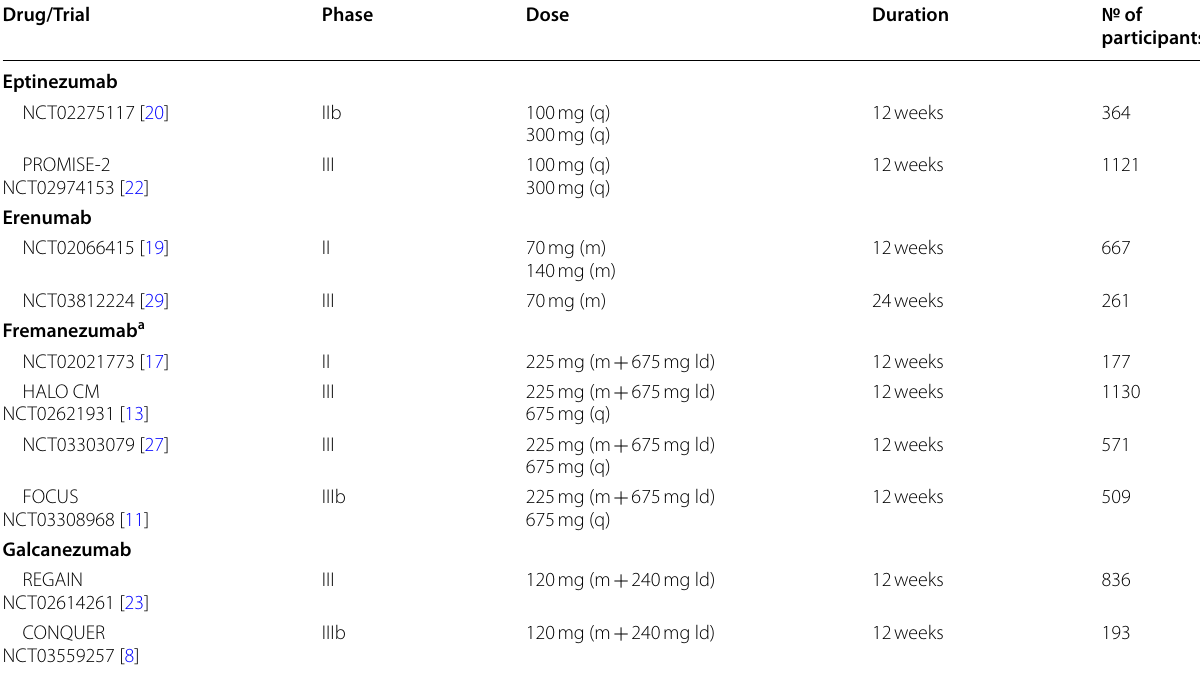
Table 5 Randomized placebo‑controlled phase II and III clinical trials in individuals with chronic migraine